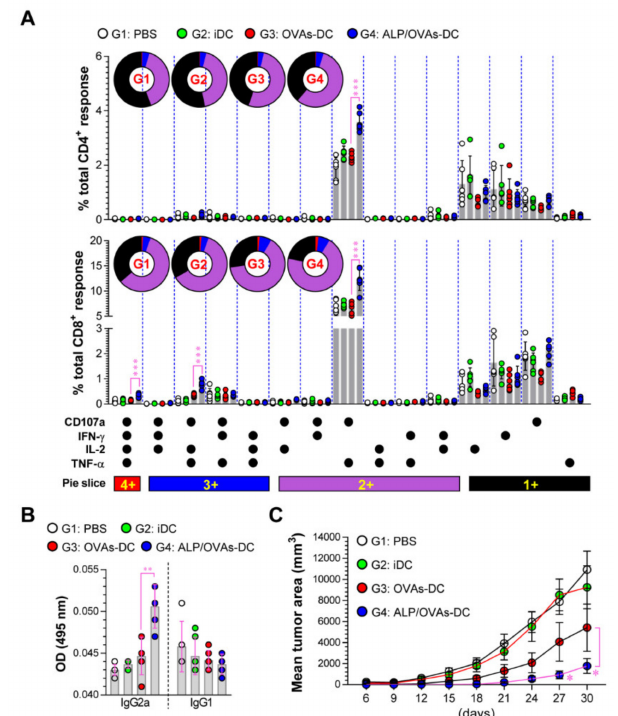
Figure 5. Immunization with ALP-treated DCs induces a robust anti-tumor e ff ect and immunity. ( A ) Two weeks after the final immunization, single cells obtained from PBS-, iDC-, OVAs-DC-, and ALP / OVAs-DC-immunized mice were stimulated ex vivo with OVA peptides for 6 h. The percentage of OVA-specific CD3 + CD4 + and CD3 + CD8 + T cells producing CD107a, IFN- γ , IL-2, or TNF- α was analyzed in accord with the gating strategy described in Figure S1 (Supplementary Materials). Pie charts indicate the mean frequencies of CD4 + and CD8 + T cells co-expressing IFN- γ , TNF- α , IL-2, and CD107a. ( B ) Serum samples were analyzed using ELISA for OVA 323–339 -specific IgG2a and IgG1 antibodies in each immunized mouse. The mean ± SD ( n = 6 mice / group) shown are representative of 2 independent experiments. ( C ) Tumor volumes in mice ( n = 10 mice / group) that received PBS (G1: white solid dot), iDC (G2: green solid dot), OVAs-DC (G3: red solid dot), and ALP / OVA-DCs (G4: blue solid dot) vs. E.G7. Tumor growth was identified by calculating the diameter of the tumor every 3 days for 30 days. The mean ± SD shown are representative of 2 independent experiments. SD; standard